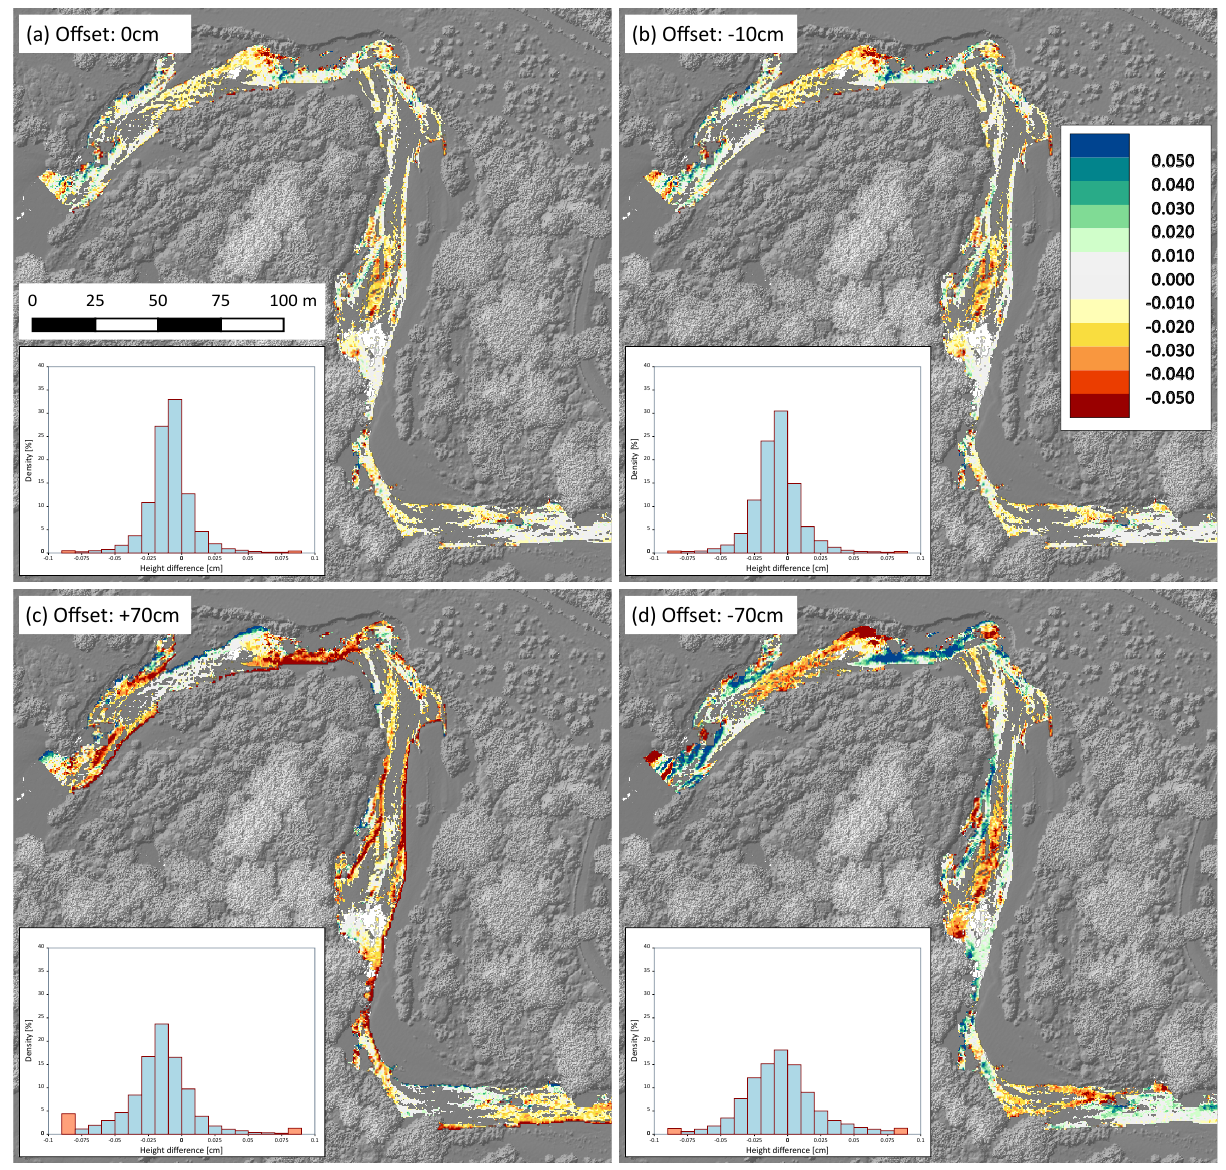
Figure 6. Color coded height differences between strips 13 (channel 1) and 18 (channel 1) derived from points classified as ground after refraction correction based on the correct (a) and vertically shifted water surface models (b, c, d). Image background: superimposition of DSM heights and shaded relief derived from IR